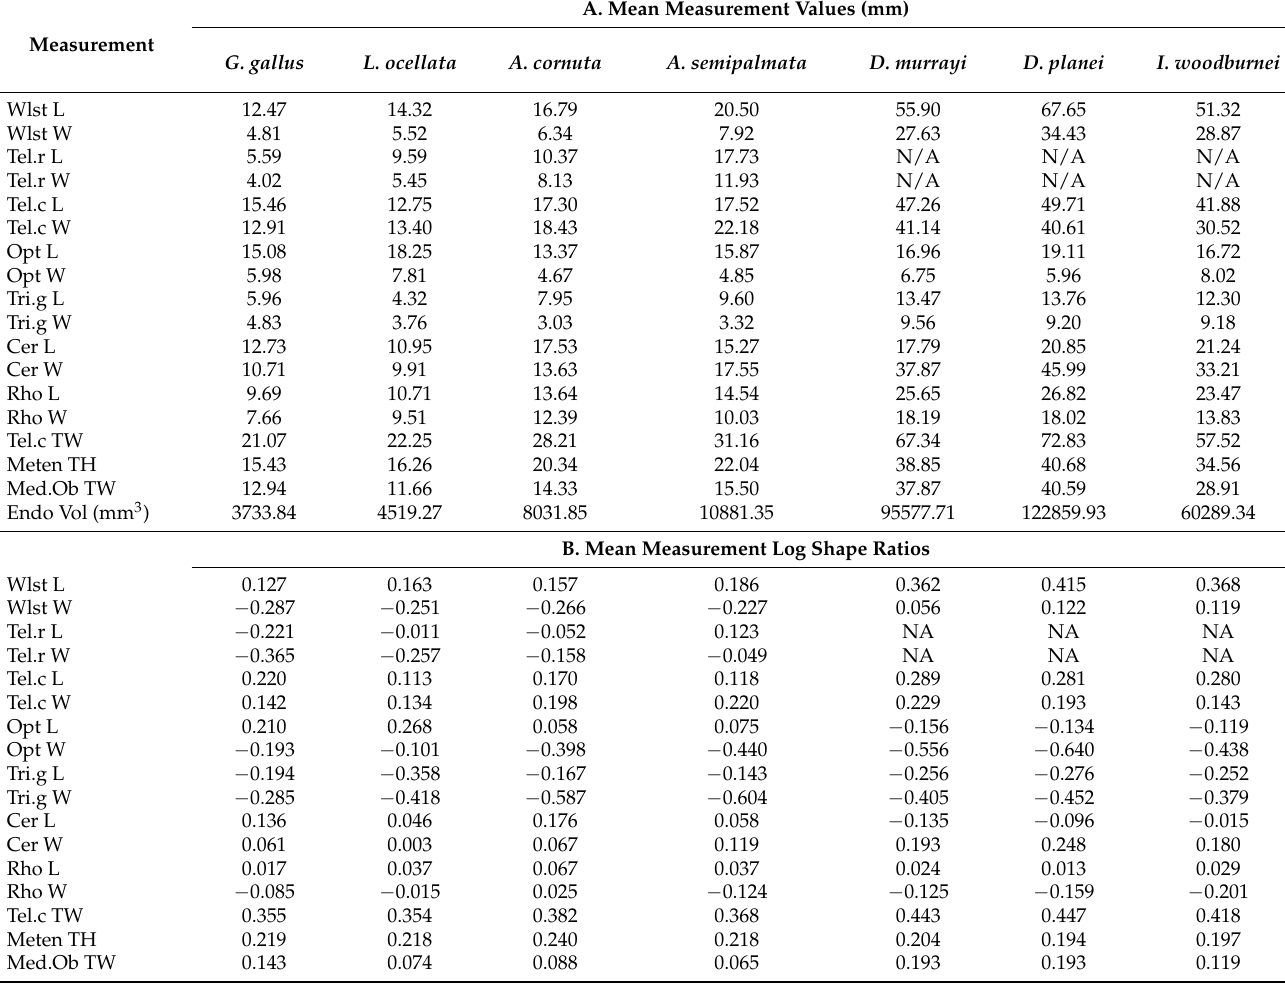
Table 1A). Size-standardised mean Measurement log shape ratios were calculated by the log shape ratios method [56], where species Measurement values were divided by species endocast total volume values and log 10 transformed [57] (p. 99), [58] (p. 117). The log shape ratio approach produces size-standardised shape variables from univariate data and is analogous with the Procrustes superimposition method for multivariate Lm data (i.e., GPA; see Section 2.7.1 below), where both methods correct for size while retaining shape varia- tion [59] (p. 1389). Measurement log shape ratios are presented in text, in Table 1B, and plotted in SI Figures S12 and S13. Table 1. A , Mean Measurement values calculated between Slm locations for each species. B and D , respectively, Size- standardised Mean Measurement and modular Surface Area log shape ratios. Log shape ratios were calculated by the log shape method (see Section 2.6.2). C , Mean modular Surface Areas computed directly from endocast surfaces (see Section 2.6.3). All bilateral structure data (i.e., wulst, rostral and caudal telencephalon, optic lobe, and